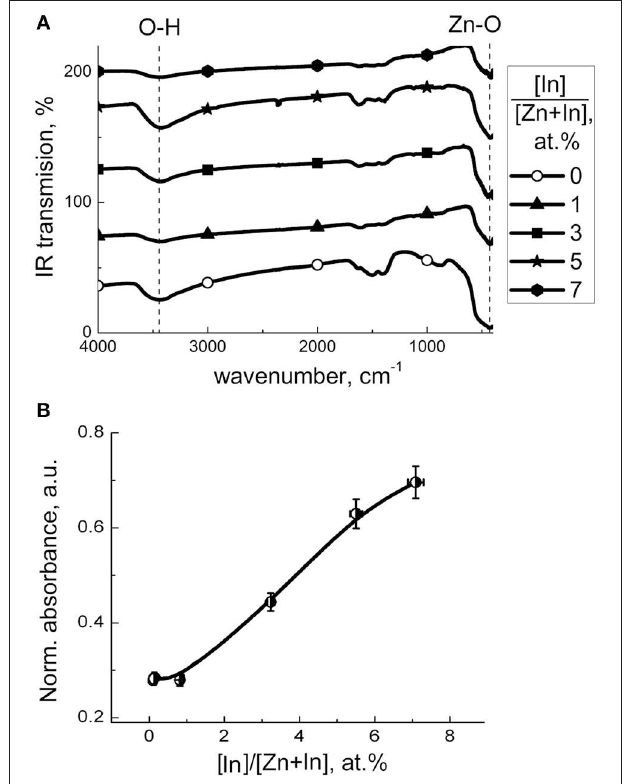
FIGURE 5 | (A) FTIR transmission spectra of zinc oxide modified by different amount of In 2 O 3 . (B) IR absorbance at OH-stretching vibrational peak (3,400 cm − 1 ) normalized to that at lattice Zn-O peak (460 cm − 1 ) in relation to the content of indium oxide in ZnO/In 2 O 3 .